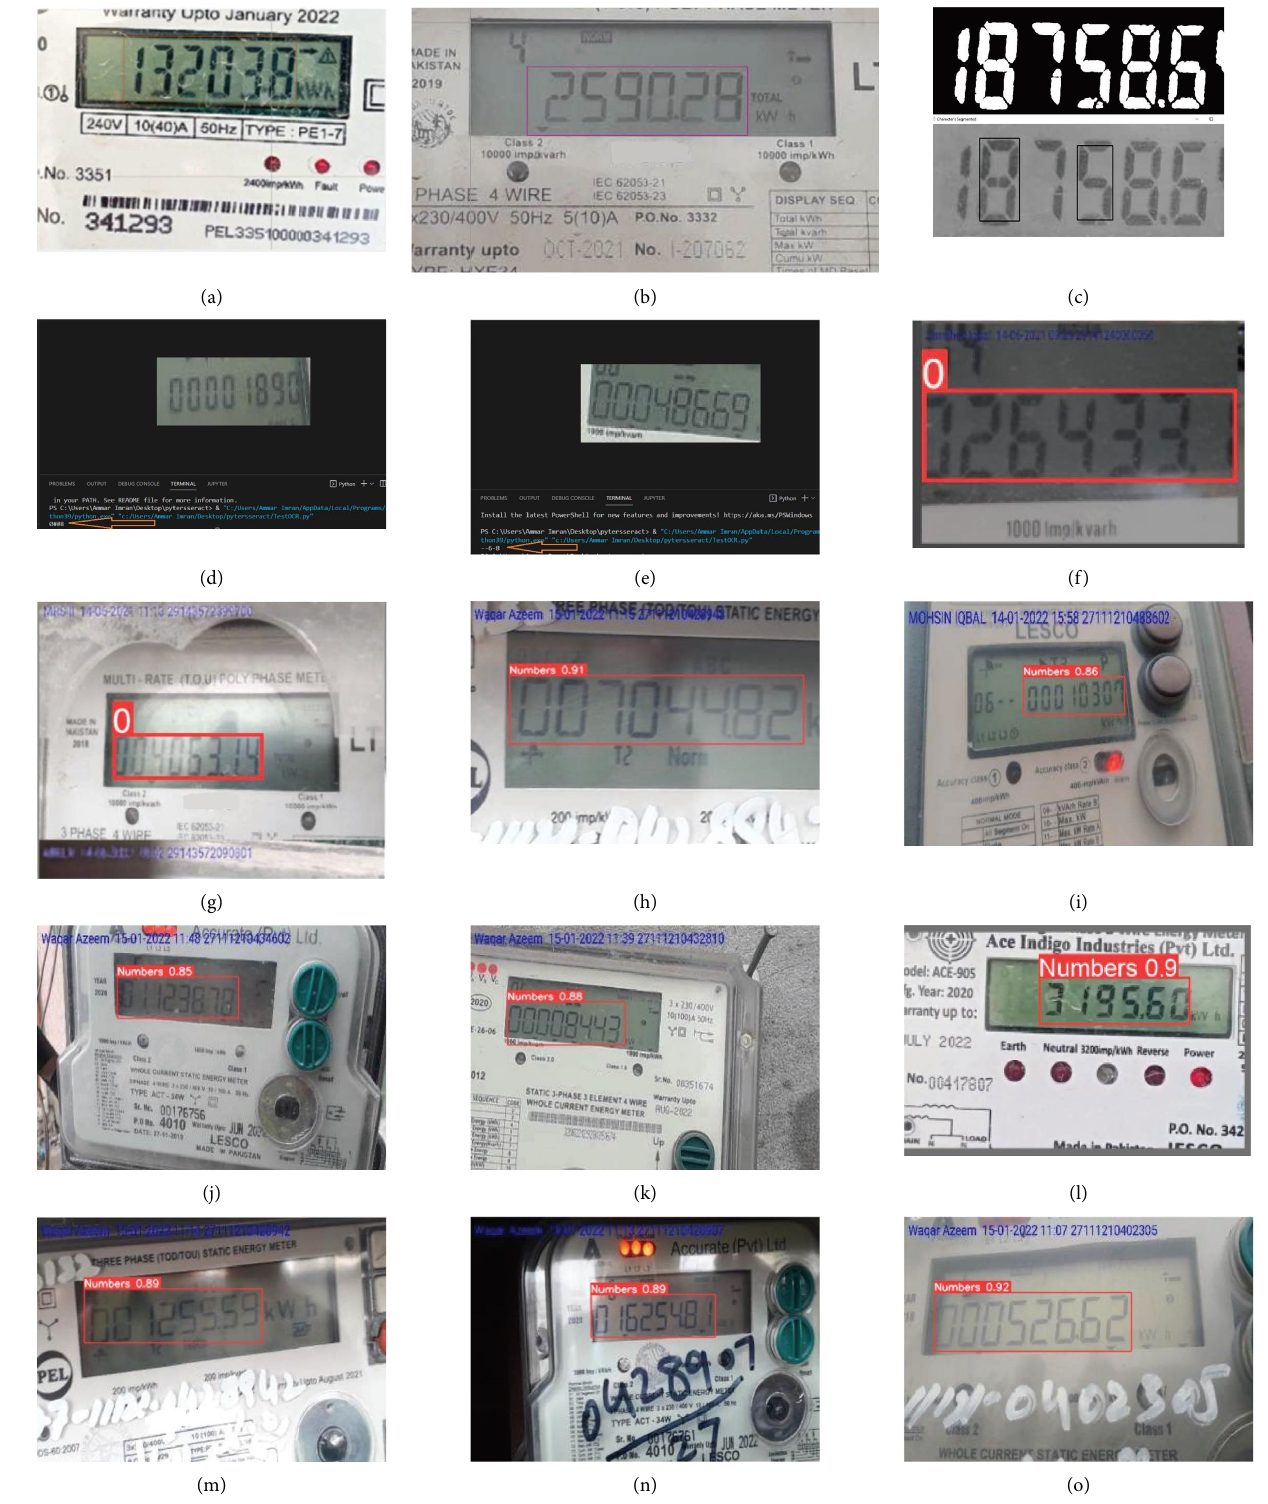
Figure 11: Comparison results of state-of-the-art algorithms on real-world meter reading image data. (a) Nanonets result 1. (b) Nanonets result 2. (c) Fast-OCR result. (d) PyTesseract result 1. (e) PyTesseract result 2. (f) RCNN result 1. (g) RCNN result 2. (h) YOLOv5 result 1.